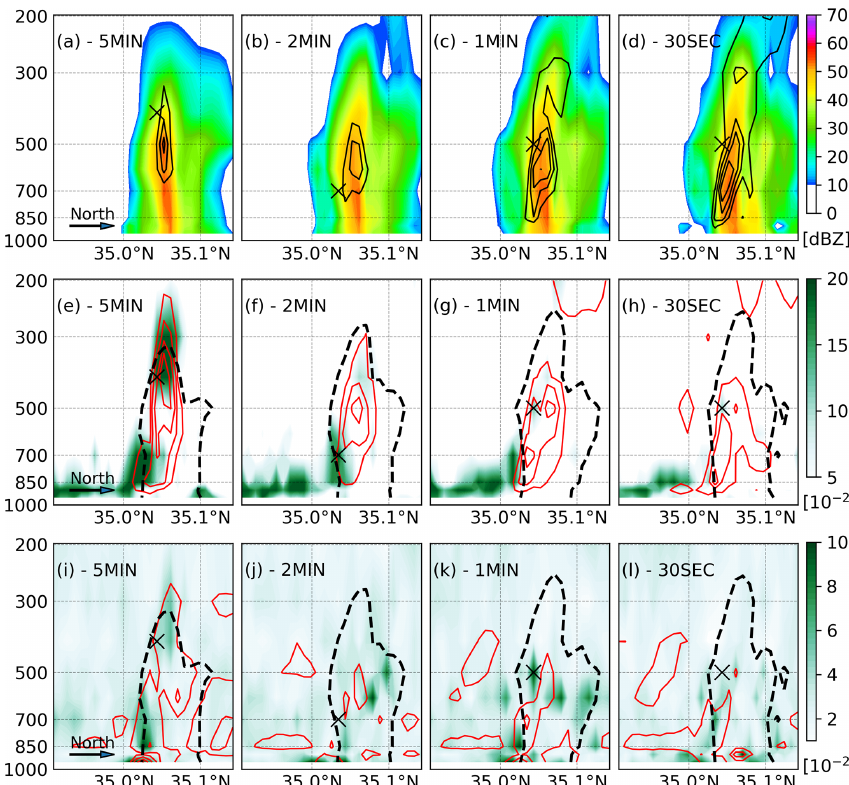
Figure 2. (a–h) South–north vertical cross section along the black line indicated in Fig. 1b–d at 05:30UTC for (a–d) first-guess ensemble mean reflectivity ( Z ; shades; dBZ) and vertical velocity ( W ; contours every 2.5ms − 1 ). (e–h) Vertical velocity KLD (shades; 10 − 2 ) and ensemble spread (red contours at 1.0, 2.5, 5.0, and 10.0ms − 1 ). (i–l) Temperature KLD (shades; 10 − 2 ) and ensemble spread (red contours at 0.2, 0.5, 1.0, and 2.0K). Blacked dashed contours indicate reflectivity over 30dBZ. The black cross in panels (i) – (l) indicates the location of the maximum KLD within the grid points at which Z >